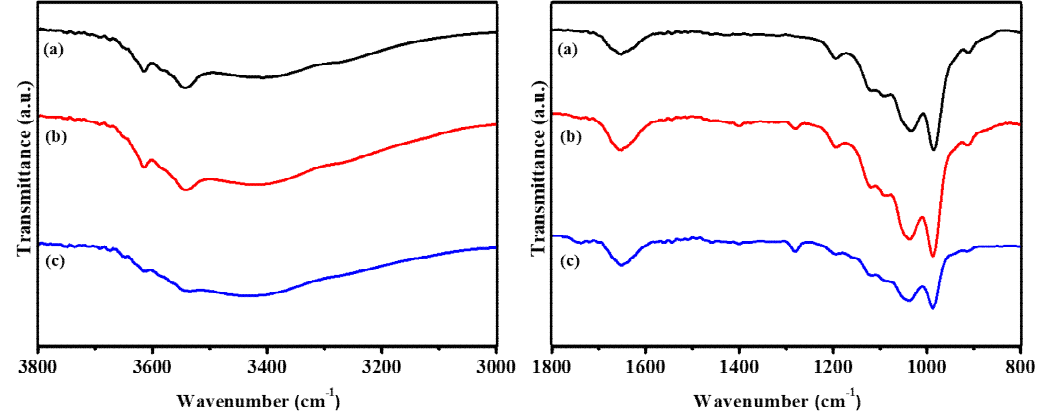
Figure 3. Infrared spectra (FTIR) of ( a ) Palygorskite, ( b ) TiO 2 –Pal, and ( c ) ZrO 2 –TiO 2 –Pal.